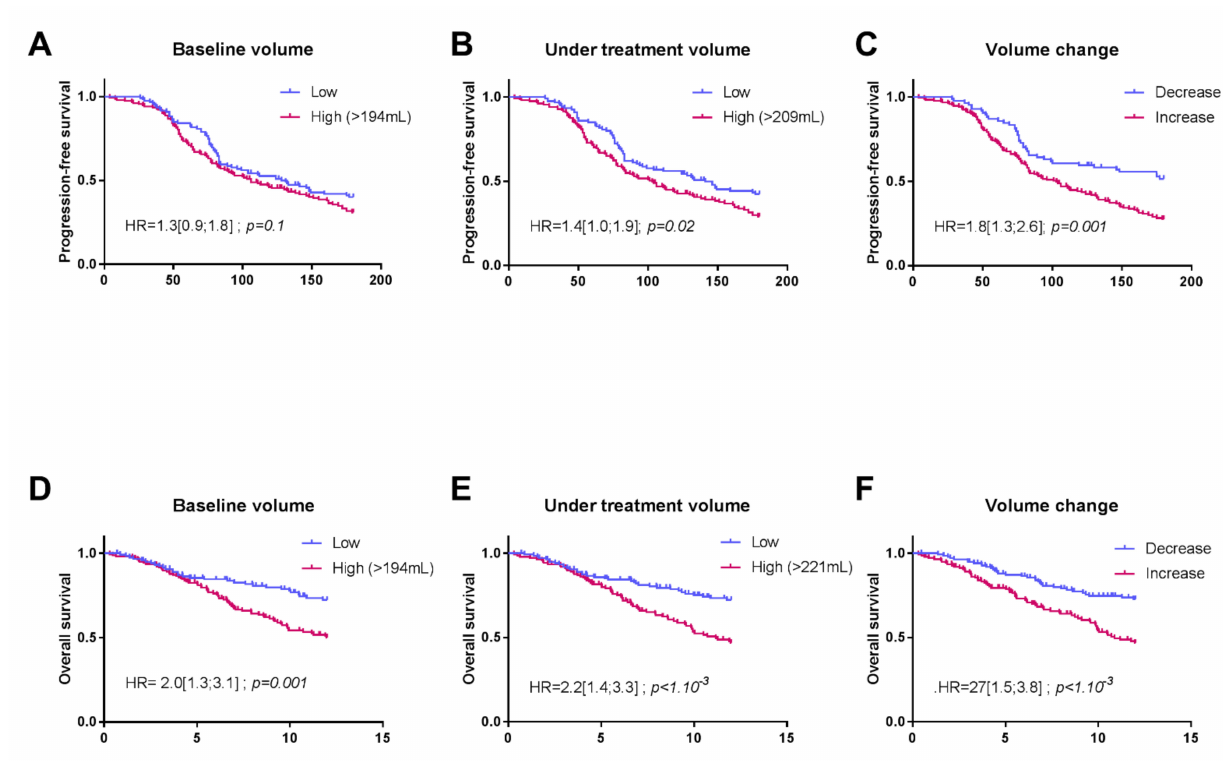
Figure 3. Kaplan–Meier curves for progression-free survival (PFS) ( A – C ) and overall survival (OS) ( D – F ), with patients stratified according to their splenic volume in the following order: baseline volume, volume during treatment, and volume